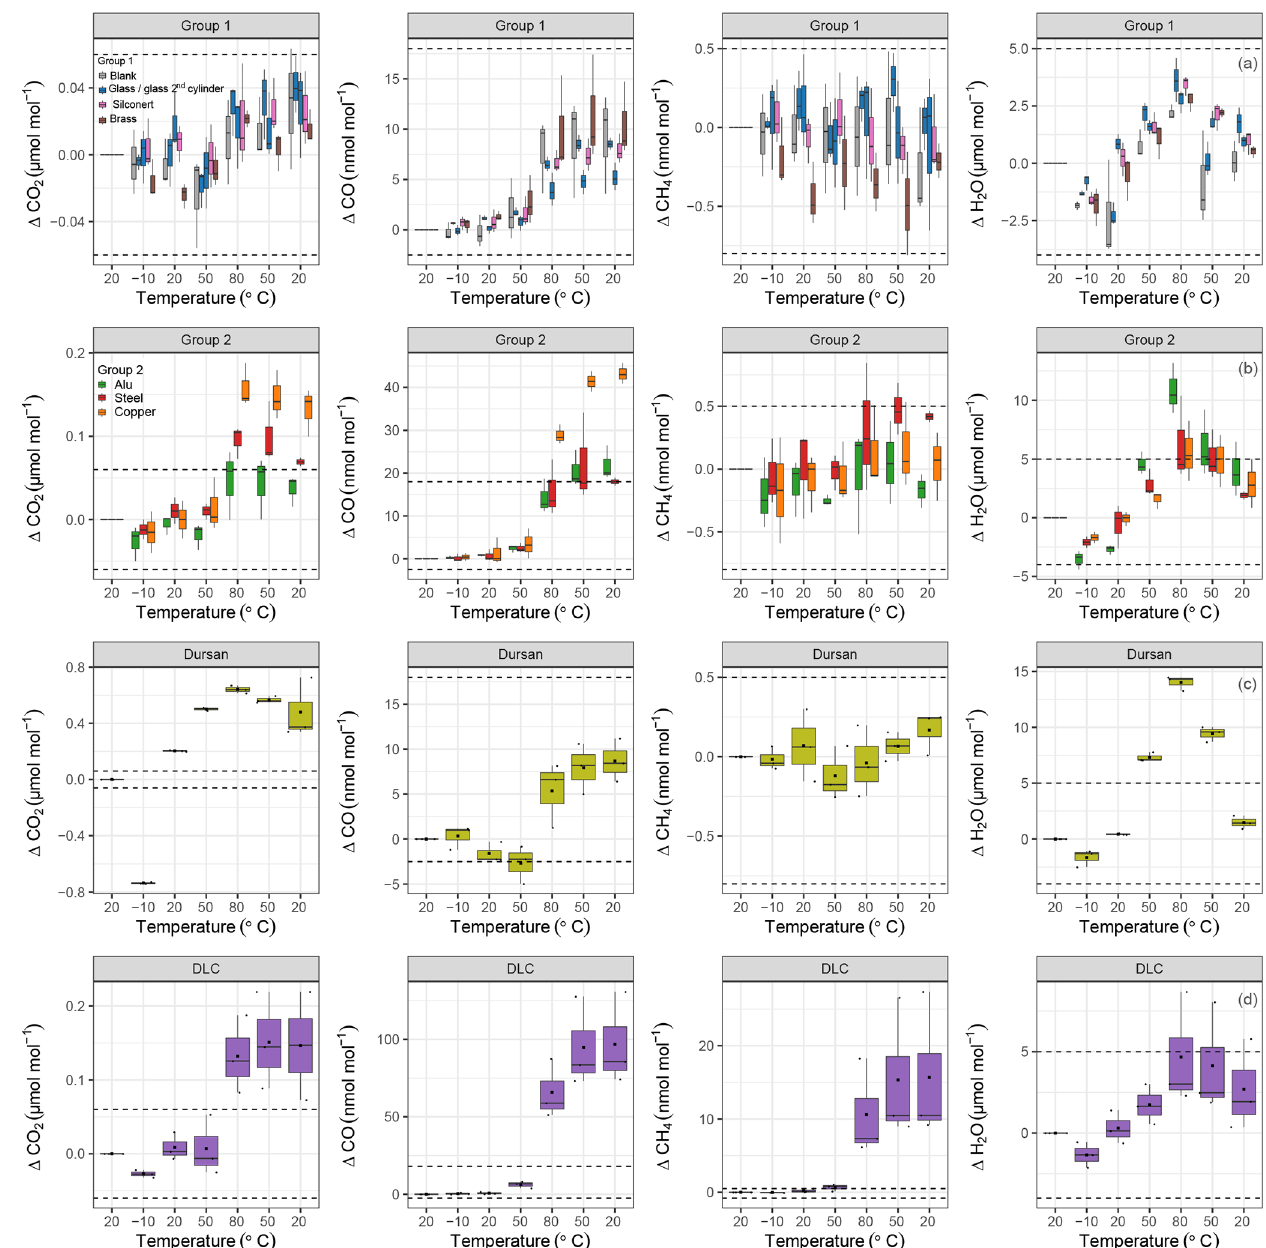
Figure 6. Temperature experiments grouped according to temperature response. (a) Group 1 materials are blank cylinder (gray), glass (blue), SilcoNert ® 2000-coated steel (pink), and brass (brown). (b) Group 2 materials are aluminum (green), stainless steel (red), and copper (orange). (c) Dursan ® (light green) and (d) DLC (purple) coatings on stainless steel. Dashed lines indicate the same ranges for each species. The x axes correspond to the temperature cycles (cf. Fig. 3), and the y axes show the amount fraction differences relative to the first measurement block at 20 ◦